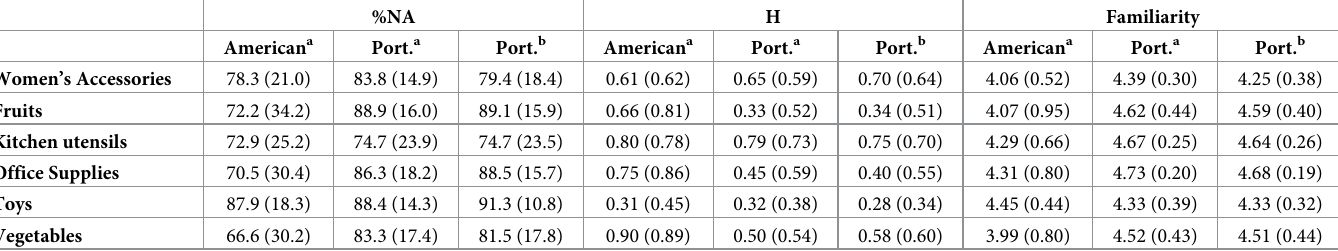
Table 5. Mean (and Standard Deviation) for name agreement scores (%NA and H ) and familiarity ratings for each category and each